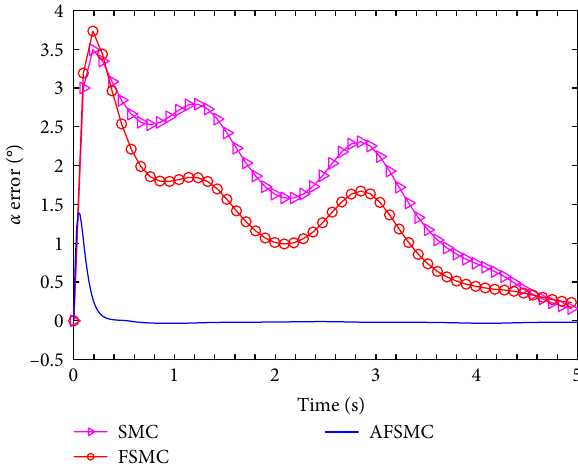
Figure 15: The tracking response of the third limb q